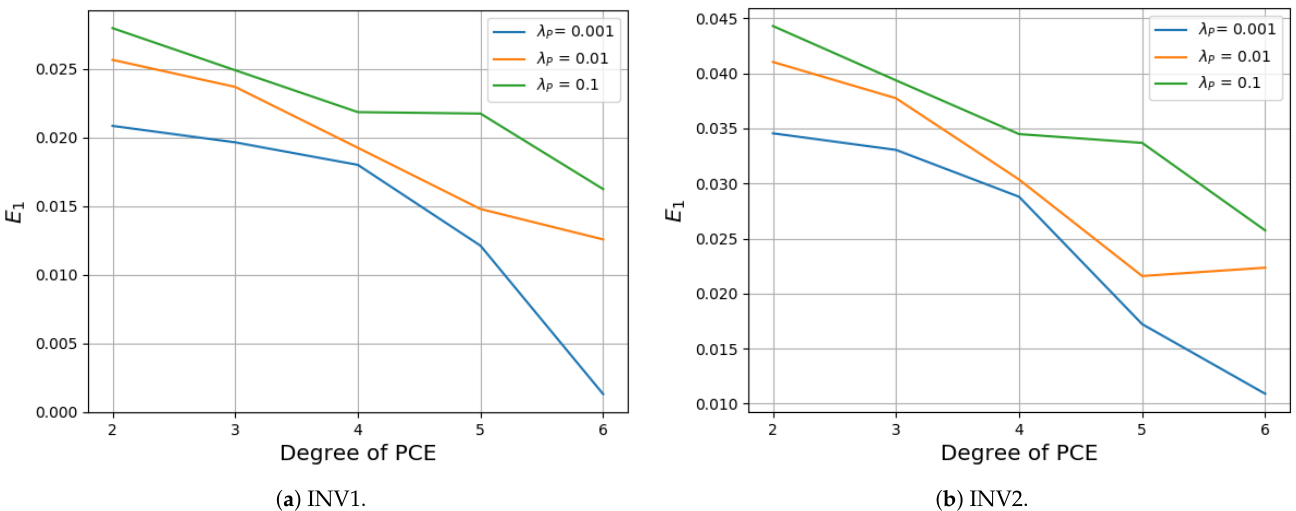
Figure 8. Absolute mean error for degree and regularization parameters.